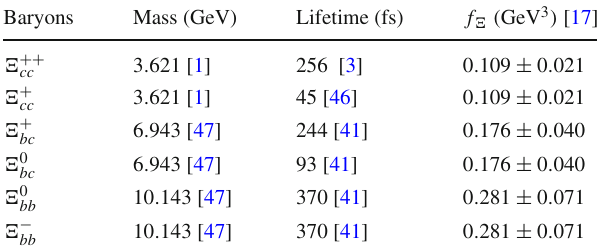
Table3 Masses,lifetimesanddecayconstantsofdoublyheavybaryons